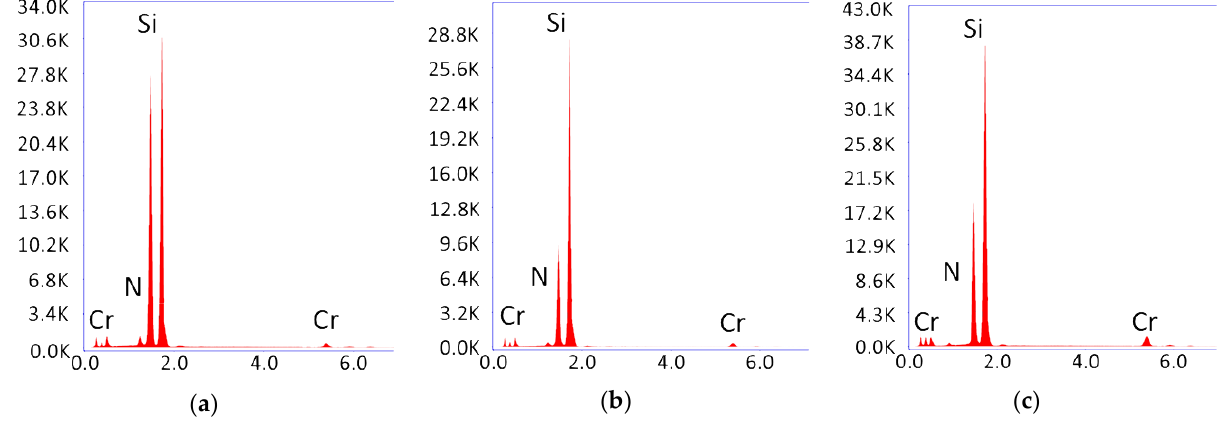
Figure 5. EDAX spectrum (number of counts vs. energy levels) when using the HiPIMS power sup- ply for the deposition times of ( a ) 5 min, ( b ) 10 min, and ( c ) 15 min.